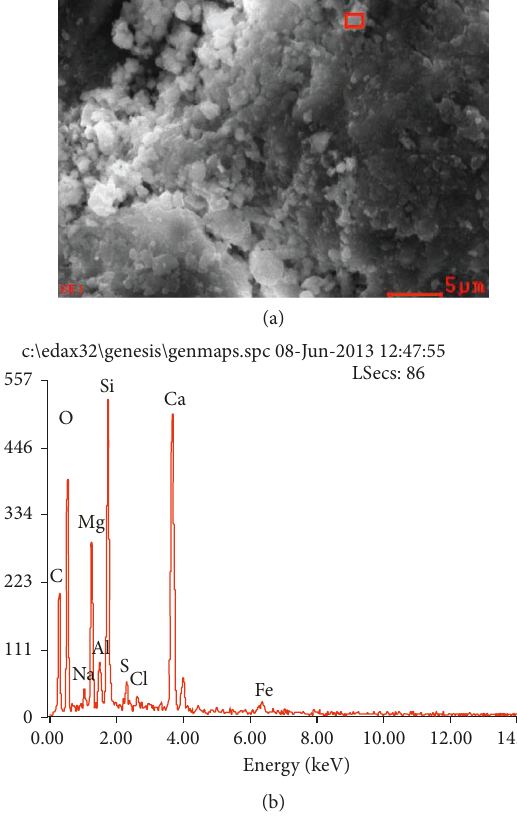
Figure 12: SEM and EDS images of the specimen in the wet-dry alternated test (150 days). (a) SEM (50,000x magnification); (b)